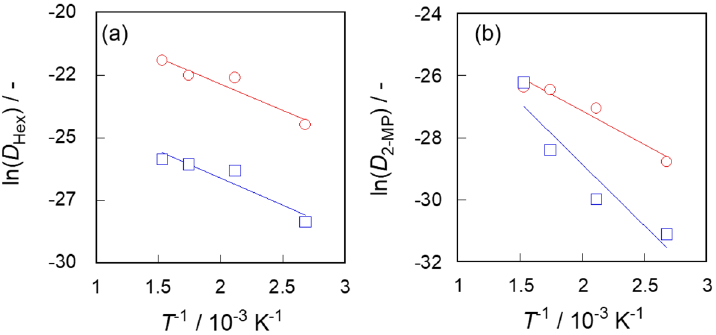
, S-1 S ; (cid:3) , S-1 M (cid:35)